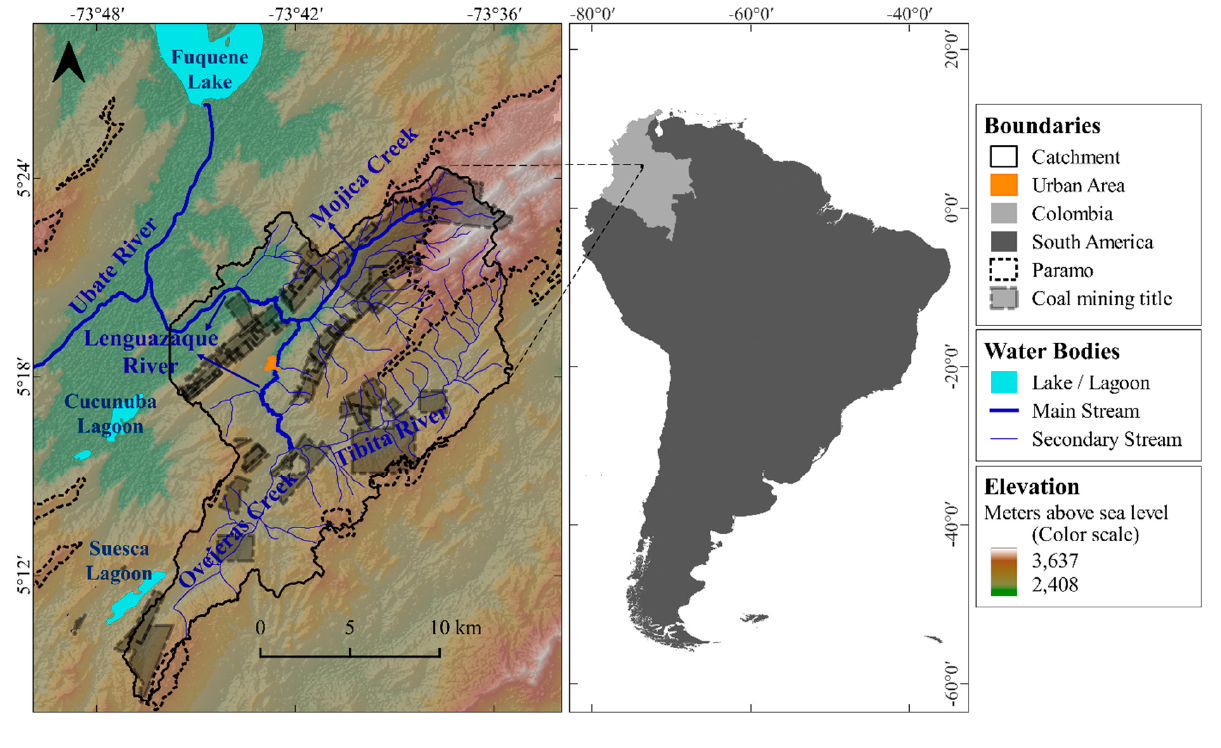
Figure 1. Location of the case study.